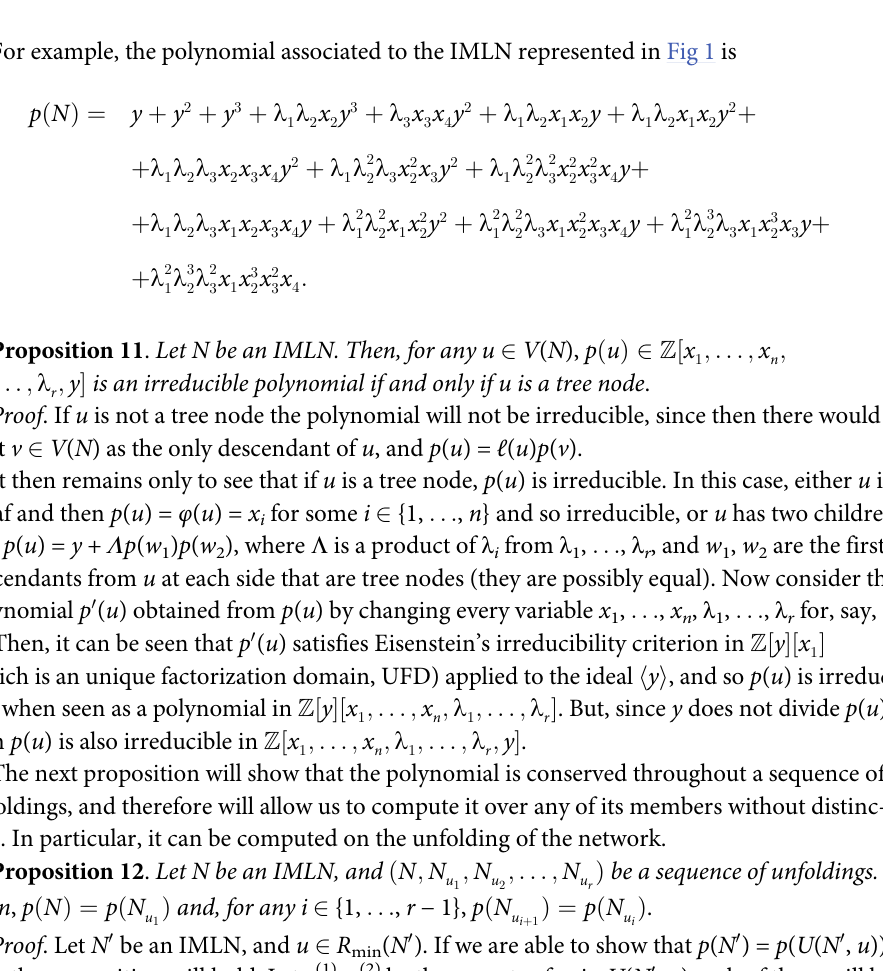
Fig 2. A multi-labelled tree derived from an internally labelled phylogenetic network. Let N be the network depicted in Fig 1. This figure depicts a decomposition of N resulting in a multi-labelled tree.